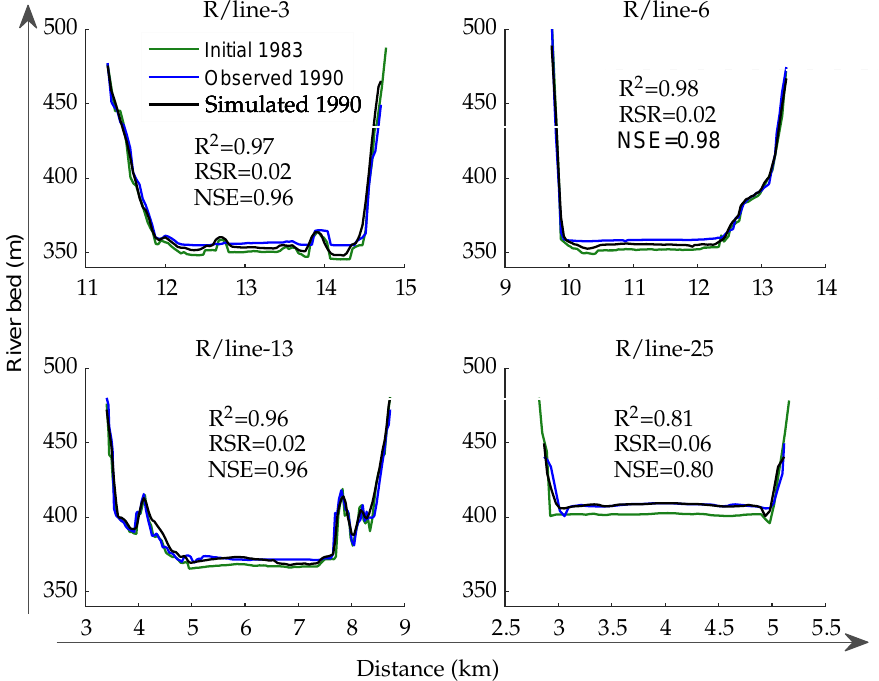
Figure 15. Comparison between measured and simulated river bed at four selected cross sections (R/line) at the end of the validation process. Measurements start orographically from left side of the reservoir.